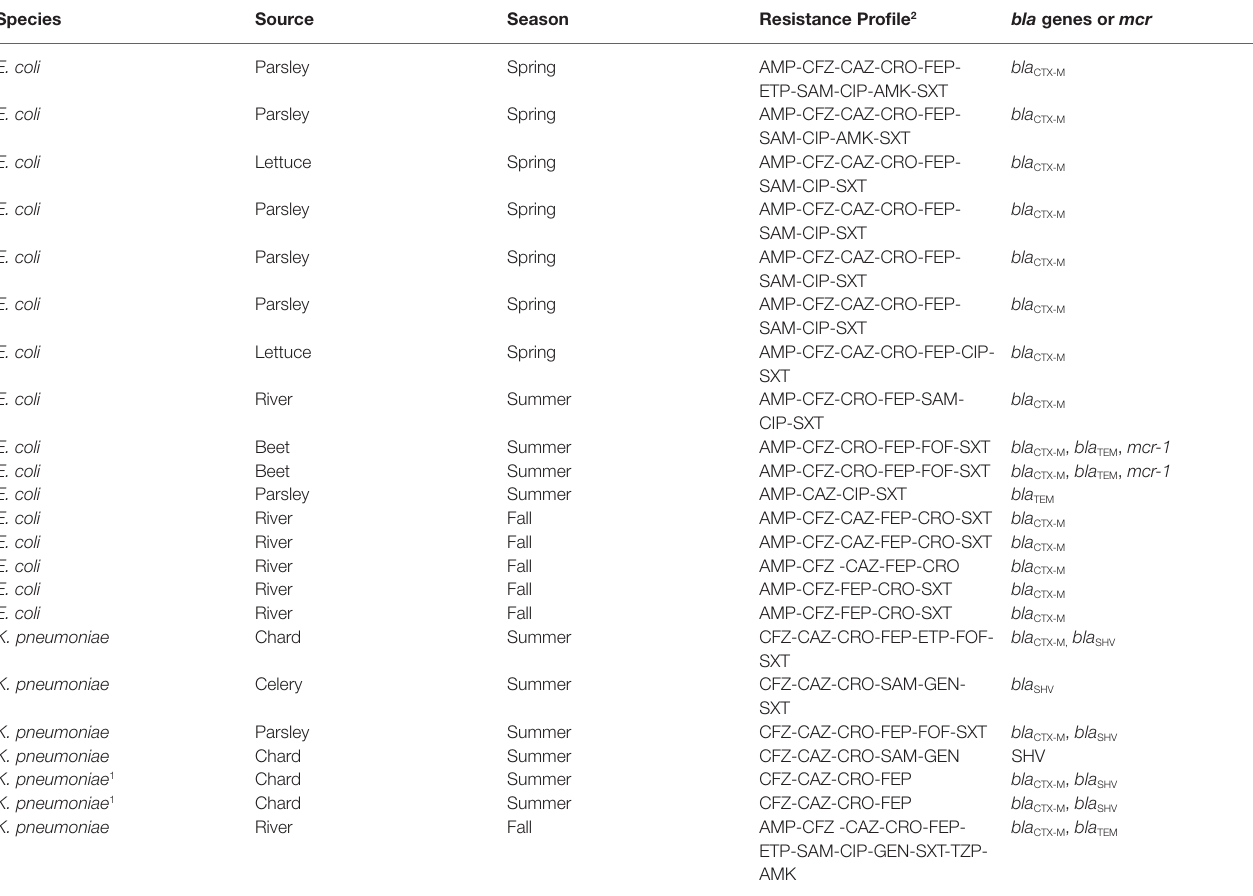
TABLE 3 | Resistance profile and presence of mcr-1 and bla ESBL genes on E. coli and K. pneumoniae isolates.